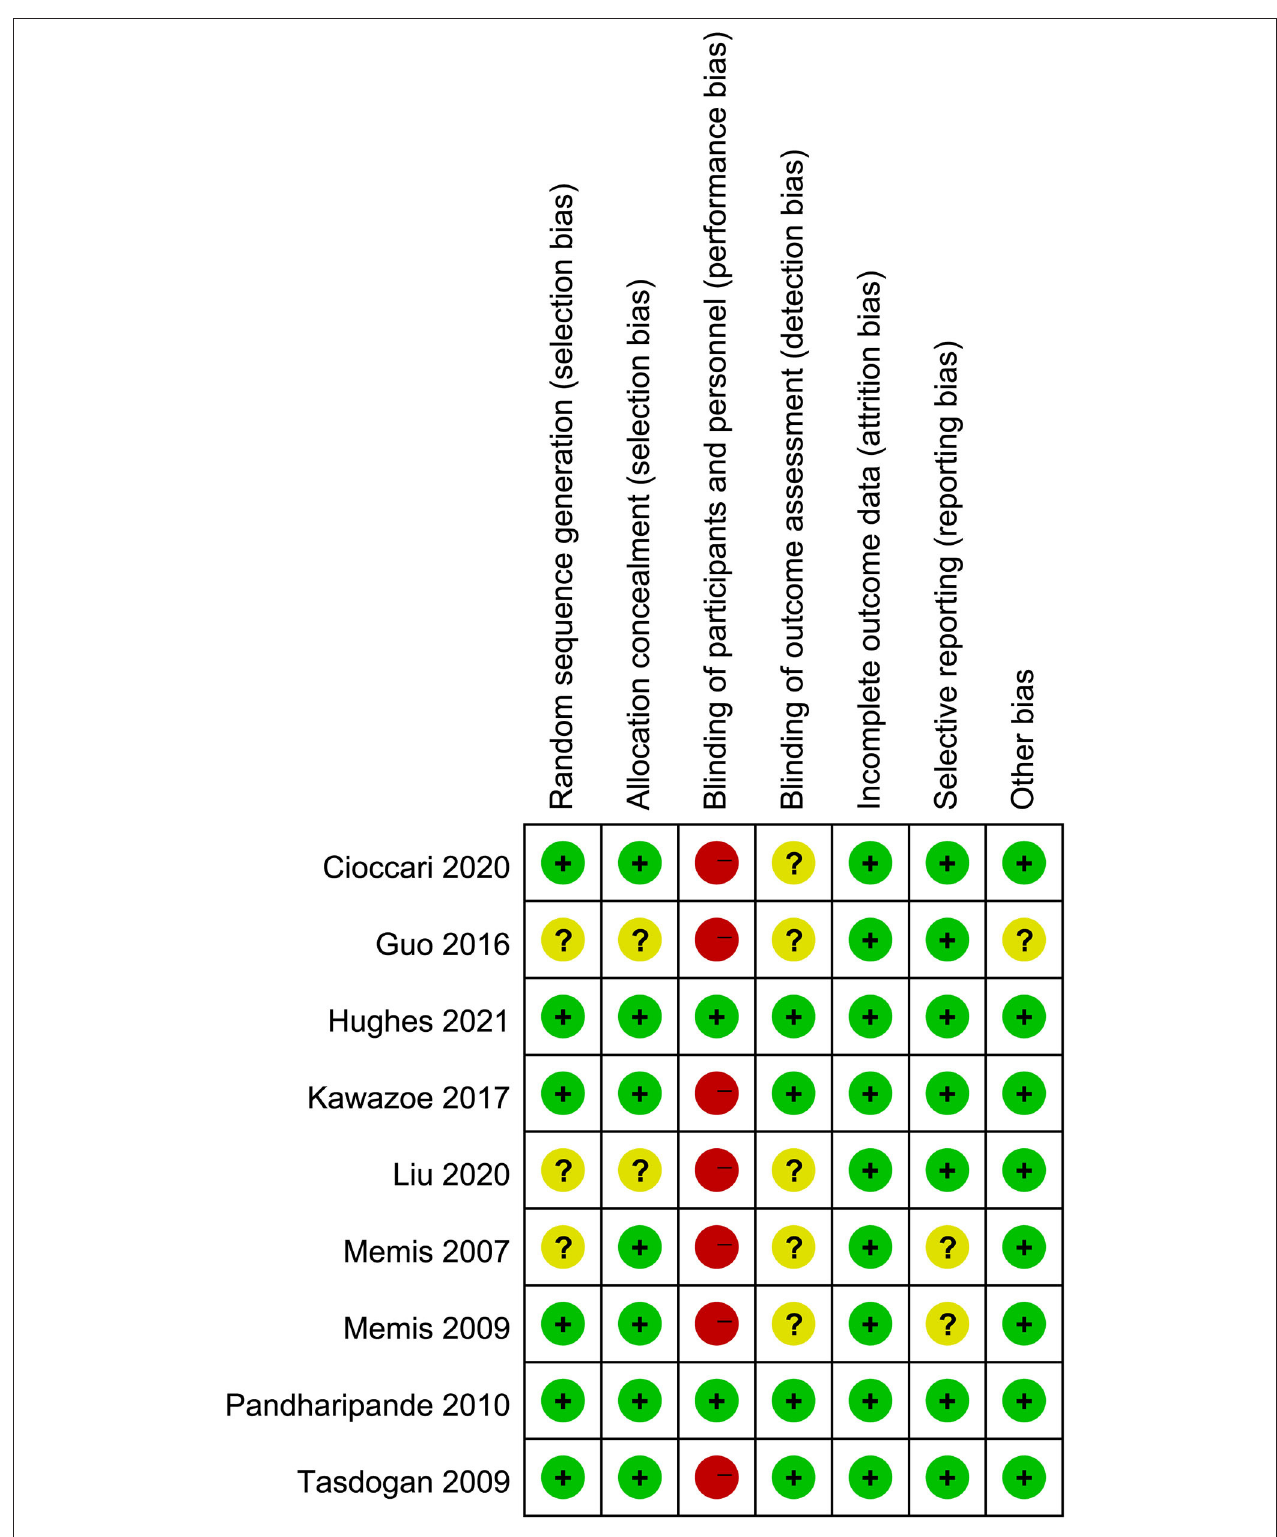
FIGURE 2 | Assessment of quality by the Cochrane risk of bias tool. Red denotes high risk, yellow unclear risk and green low risk.